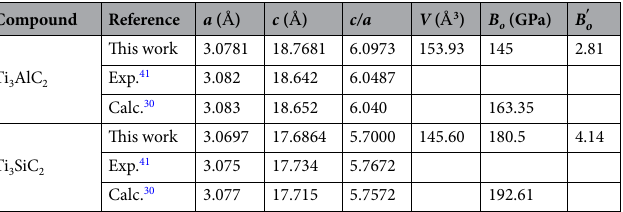
Table 1. Calculated equilibrium lattice parameters a, c , c/a ratio, volume, V , bulk modulus B o , and its pressure ′ derivative , B o and values from the literature.